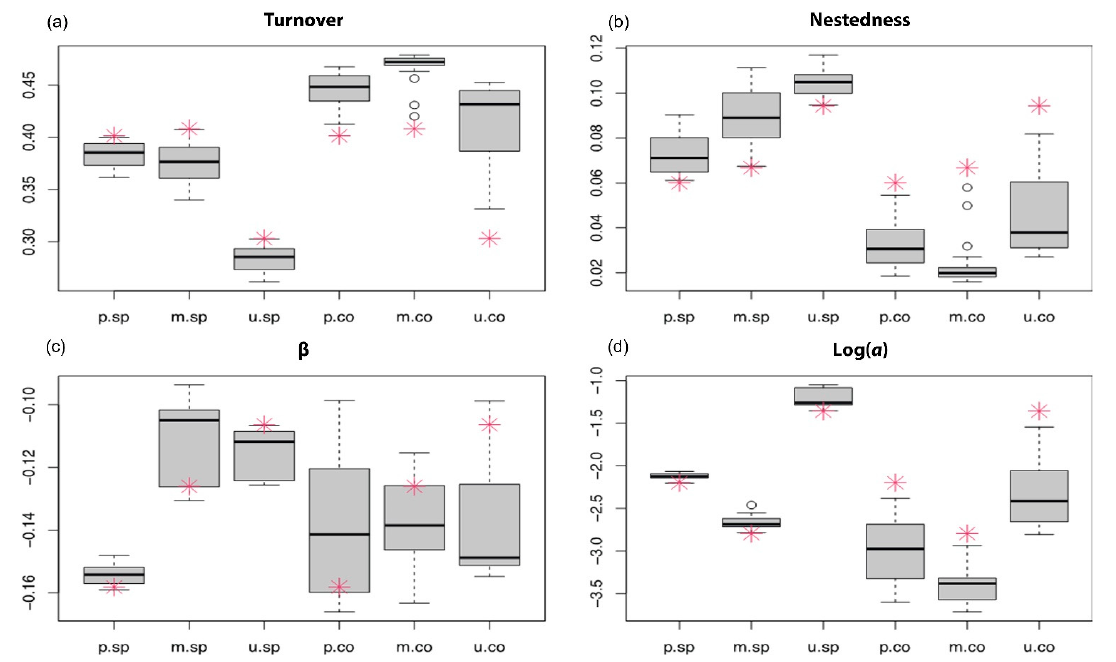
Figure 4. Comparison of turnover ( a ), nestedness ( b ), β ( c ), and log( a ) ( d ) between the original fungal functional guild communities and communities where specialists and generalists had been removed. The boxplots show the distributions of the four features in each of the fungal functional guild communities. A red star stands for an observed feature in a community. p.sp: specialists were removed for the putative plant pathogen community; m.sp: specialists were removed for the mutualistic community; u.sp: generalists were removed for the undefined saprotroph community; p.co: generalists were removed for the mutualistic community; m.co: generalists were removed for the mutualistic community; u.co: generalists were removed for the undefined saprotroph community.